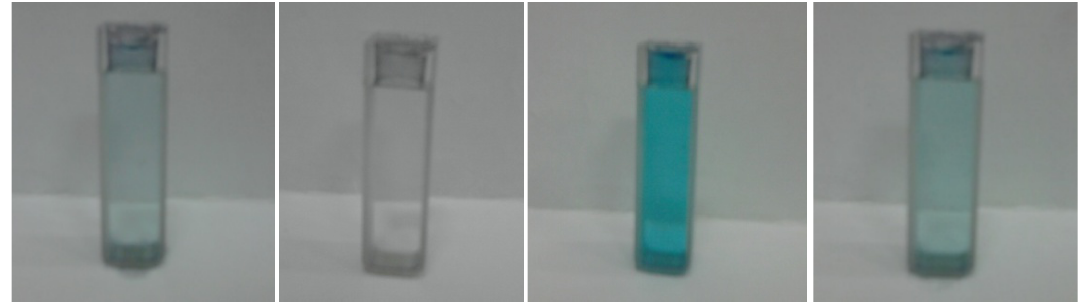
Fig. 14. From left to right, the color of the sample before being put under solar light, after 15, 25 and 50 min under solar light, respectively.